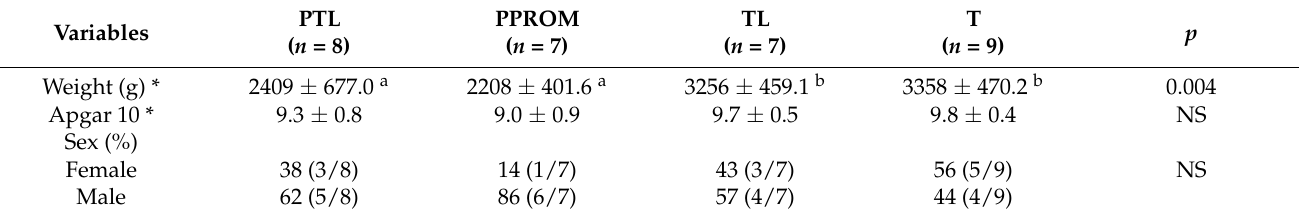
Table 2. Clinical data on the newborns included in this